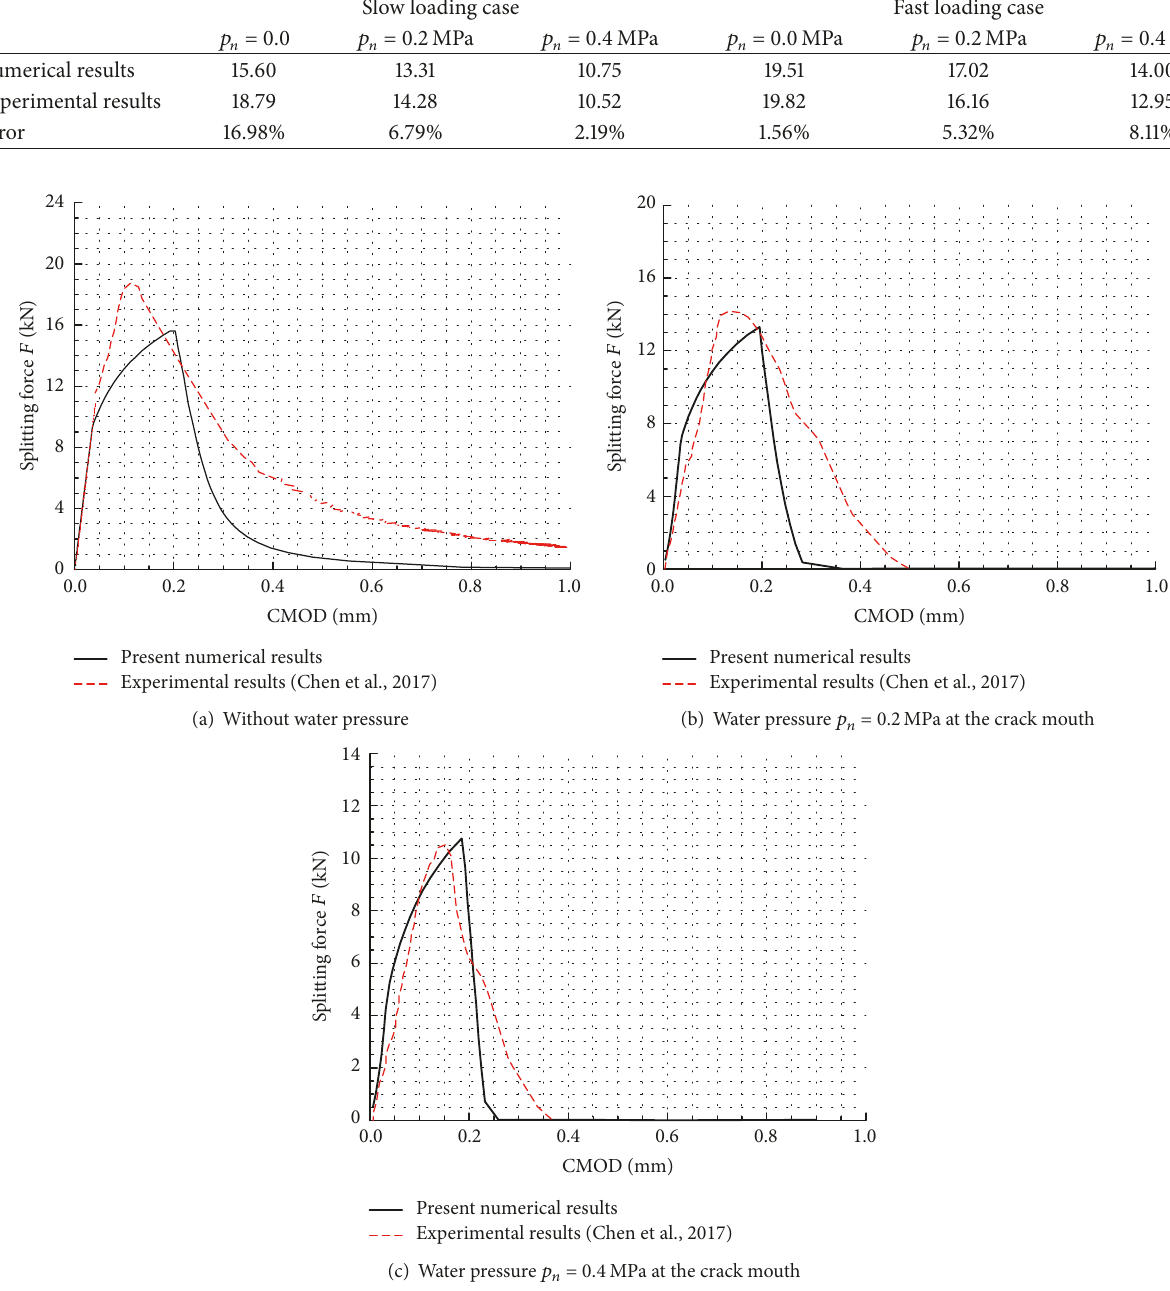
Figure 10: Splitting force versus CMOD curve for slow loading case with different water